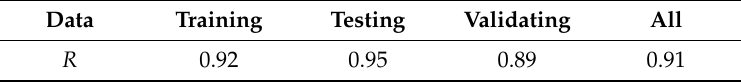
Table 4. Certificate of the second ANN model for dataset with F 15 ≤